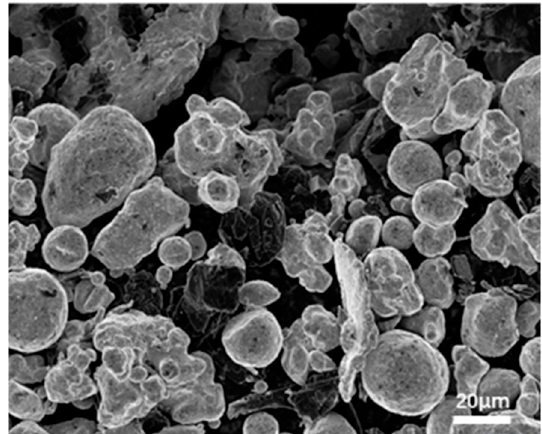
Figure 1. Morphology of the mixed Ag – C powders.